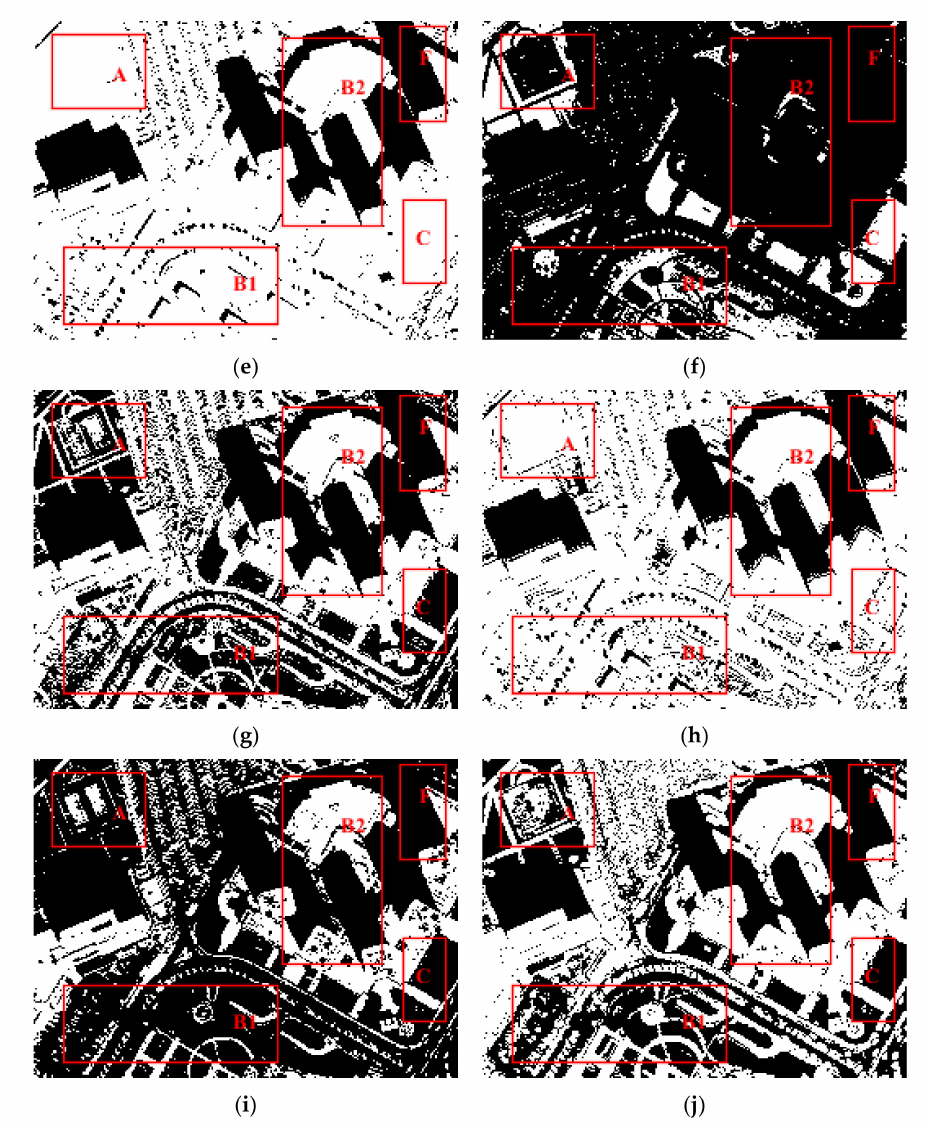
Figure 7. Shadow detection results of various shadow detection algorithms for Tripoli-2. ( a ) HIS. ( b ) HSV. ( c ) CIELCh. ( d ) YCbCr. ( e ) YIQ. ( f ) MC3. ( g ) NSVDI. ( h ) LSRI. ( i ) SDI. ( j )